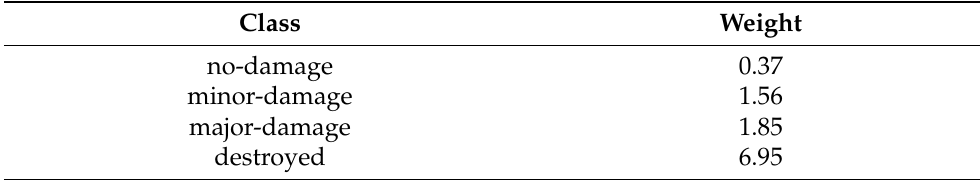
Table 4. Input class weights for Model